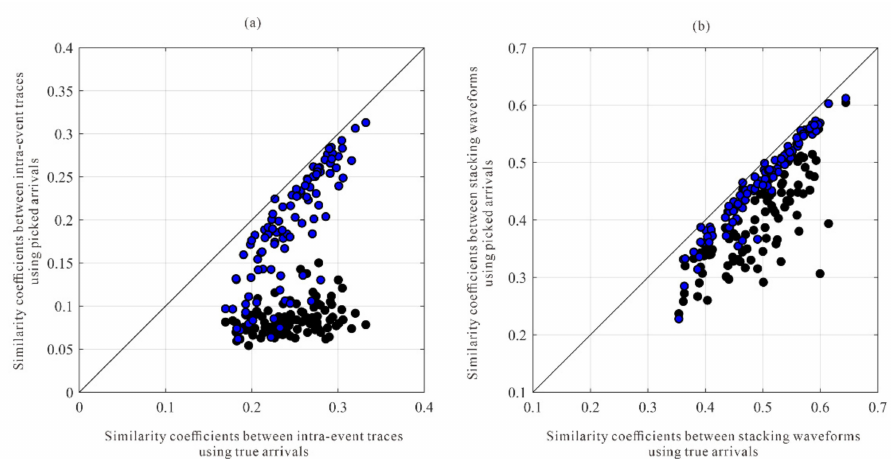
Figure 9. Quality assessments for the arrival results of different picking methods compared with the true arrivals. ( a ) the P wave similarity coefficients of intra-event traces; ( b ) the S wave similarity coefficients of intra-event traces. The black and blue circles represent the similarity coefficients calculated by those arrivals of the STA/LTA method and intra-event processing methods,